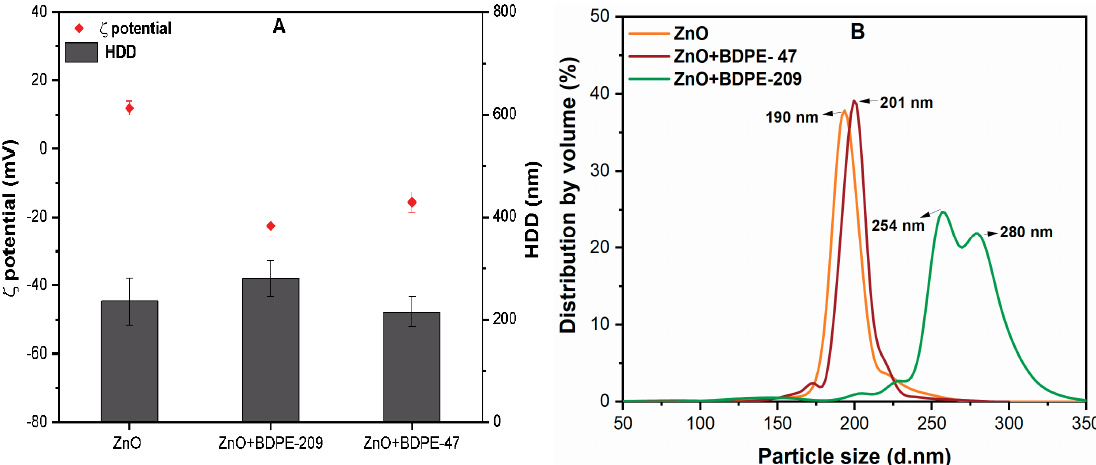
Figure 3. ( A ) Hydrodynamic diameter (HDD) of ZnO NPs (10 mg/L) with and without PBDPEs (5 mg/L) in DI water; ( B ) distribution by volume (%) of ZnO NPs in the presence of (5 mg/L) of BDPE-47 and BDPE-209 at pH 7.